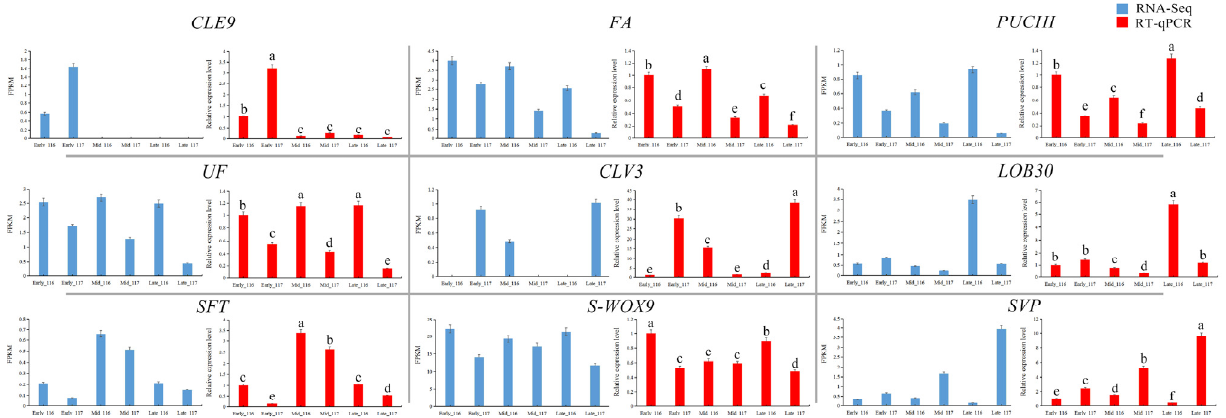
Figure 10. Comparative analysis of expression results between RNA-seq and RT-qPCR. Each bar represents the mean ± SD and different letters indicate significant differences ( t -test, p ≤ 0.05).